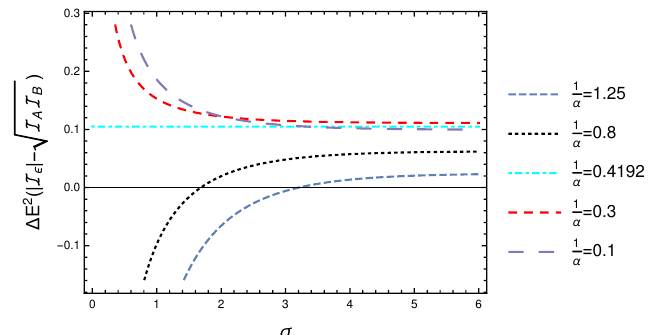
√ (cid:0) (cid:1) is plotted for two anti-parallelly |I ε | − I A I B = α . A B